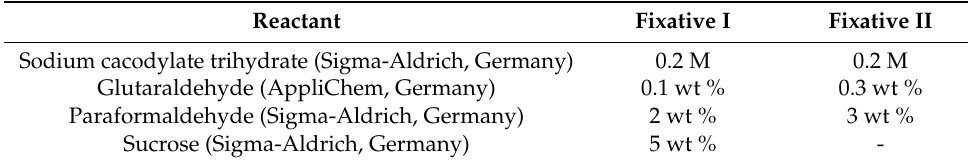
Table 3. Composition of fixative I and